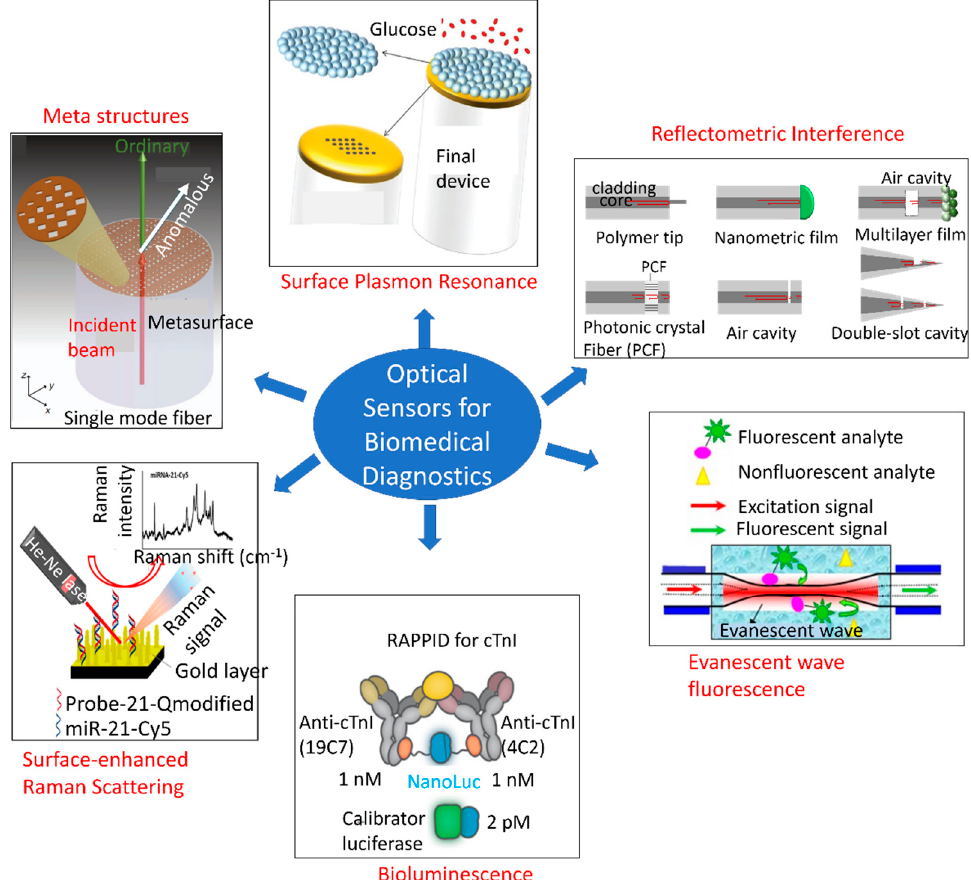
Figure 5. Overview of different types of optical sensing mechanisms based on the optical phenomenon arising from receptor–analyte interactions. This overview shows meta-structures, surface plasmon resonance, reflectometric interference [126], evanescent wave fluorescence [127], bioluminescence [128], and surface-enhanced Raman scattering (SERS) [129]. Reproduced under the terms